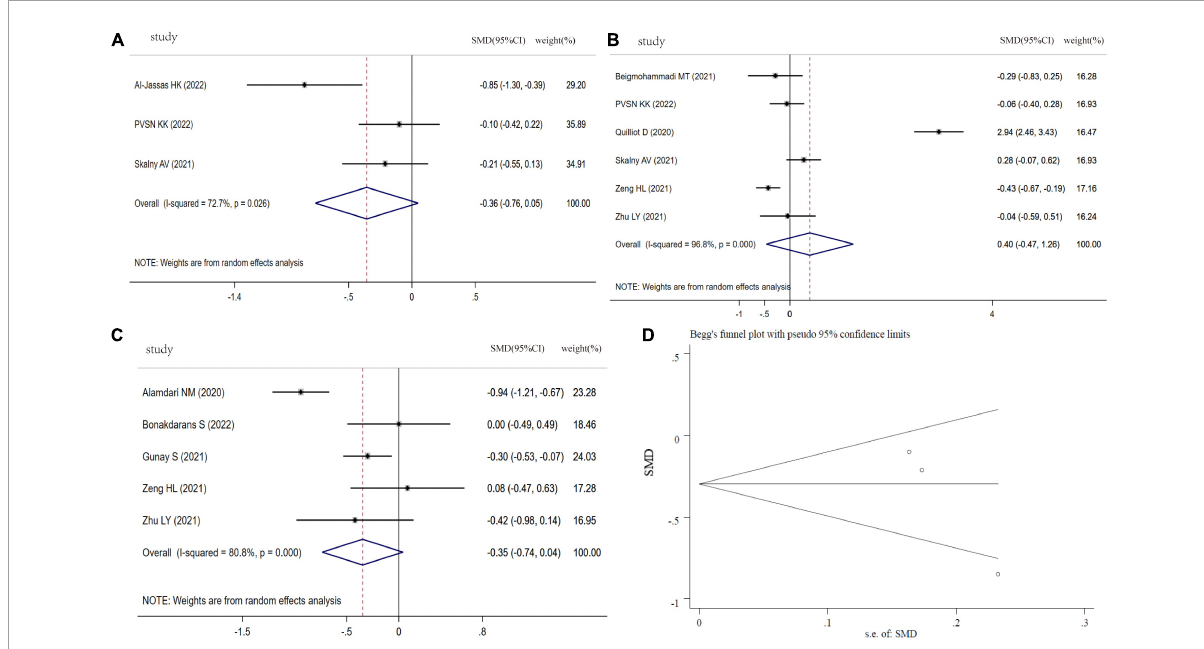
FIGURE5 Forest plot of Mg levels. (A) Mg levels between COVID-19 patients and controls; (B) Mg levels between severity status and non-severity status in COVID-19 patients; (C) Mg levels between non-survivors and survivors in COVID-19 patients; (D) funnel plot of the meta-analysis on Mg levels between COVID-19 patients and controls.